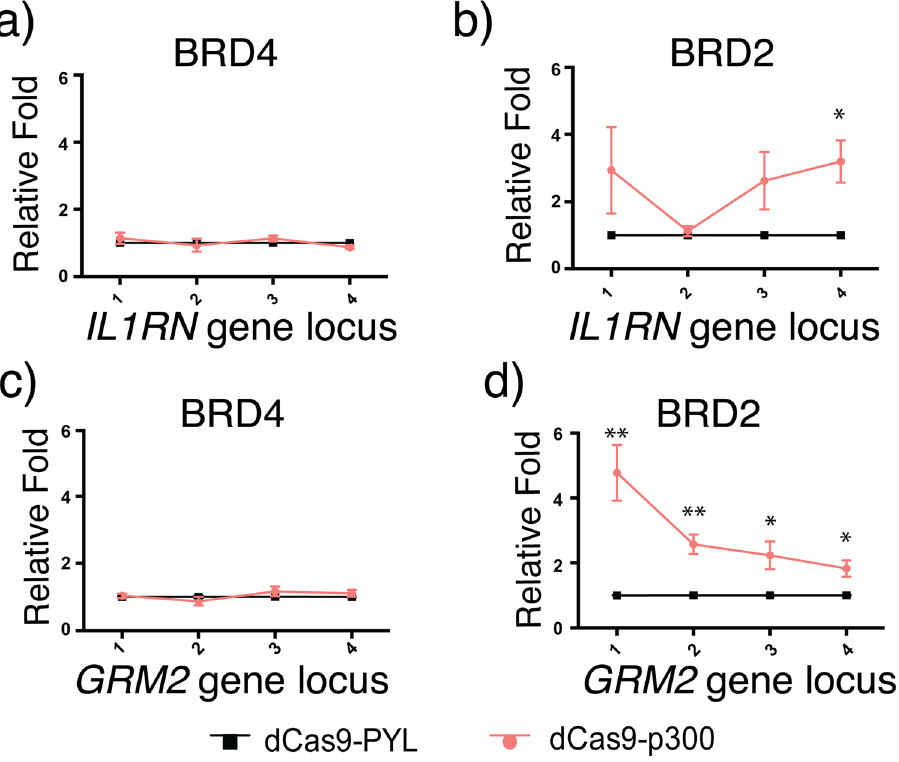
Figure 5. Recruitment of BRD proteins to dCas9-p300 targeted genome loci. Enrichment of BRD4 at ( a ) IL1RN and ( c ) GRM2 loci upon dCas9-p300 targeting. Enrichment of BRD2 at ( b ) IL1RN and ( d ) GRM2 loci upon dCas9-p300 targeting. Fold changes of BRD2 and BRD4 enrichment were calculated by normalizing results to those from samples of dCas9-PYL. Error bars represent ± s.e.m. from biological replicates (n = 3; a , b ; n = 5 for c ; n = 4 for d ). The p value less than 0.05 was marked as *, less than 0.01 as ** and less than 0.001 as